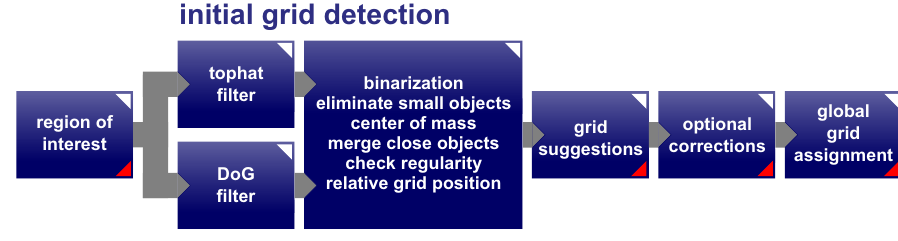
Figure 10. Flowchart of the initial grid detection. White corners indicate new processing steps and red corners indicate a necessary or optional user